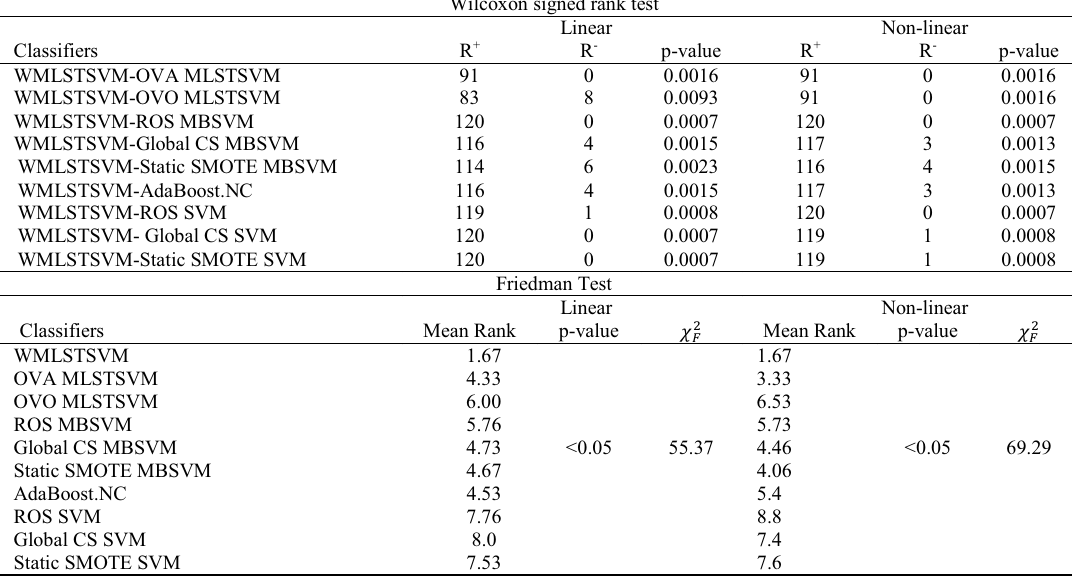
Table 6. Result of Wilcoxon signed rank test and Friedman test